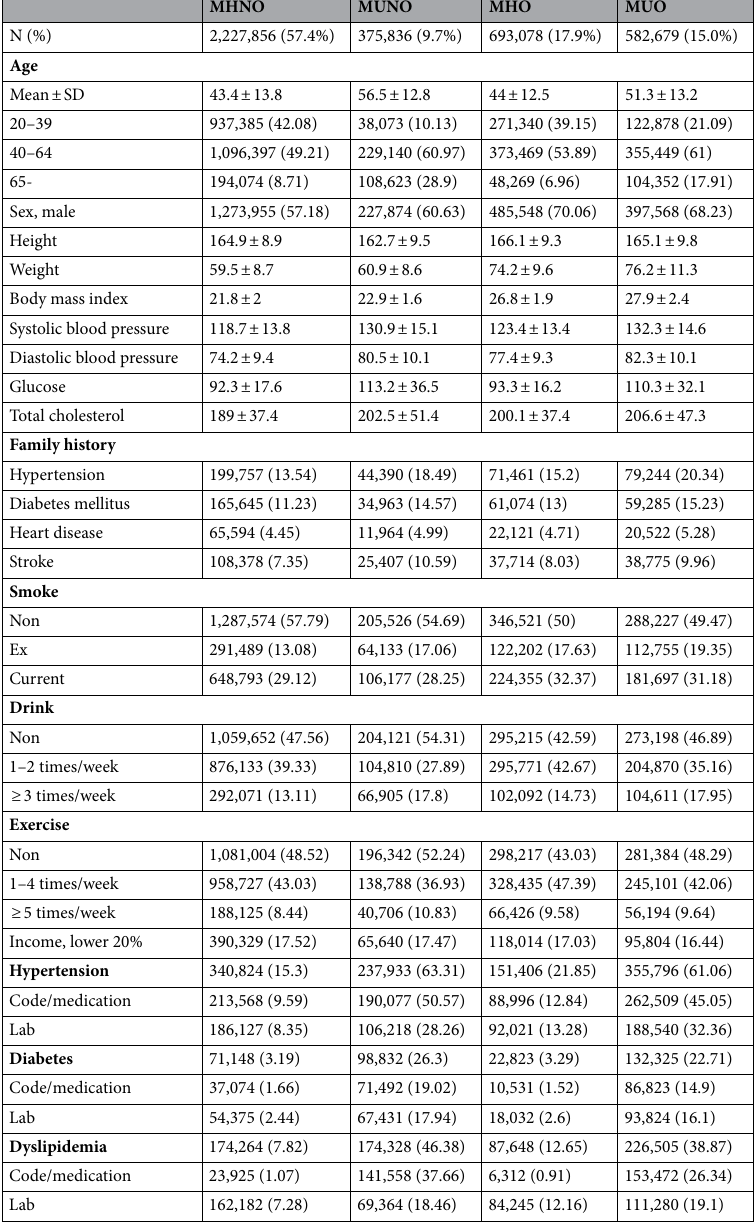
Table 1. Characteristics of subjects according to body mass index and metabolic health status. Data are expressed as the means ± SD, (%). MHNO metabolically healthy non-obese; MHO metabolically healthy